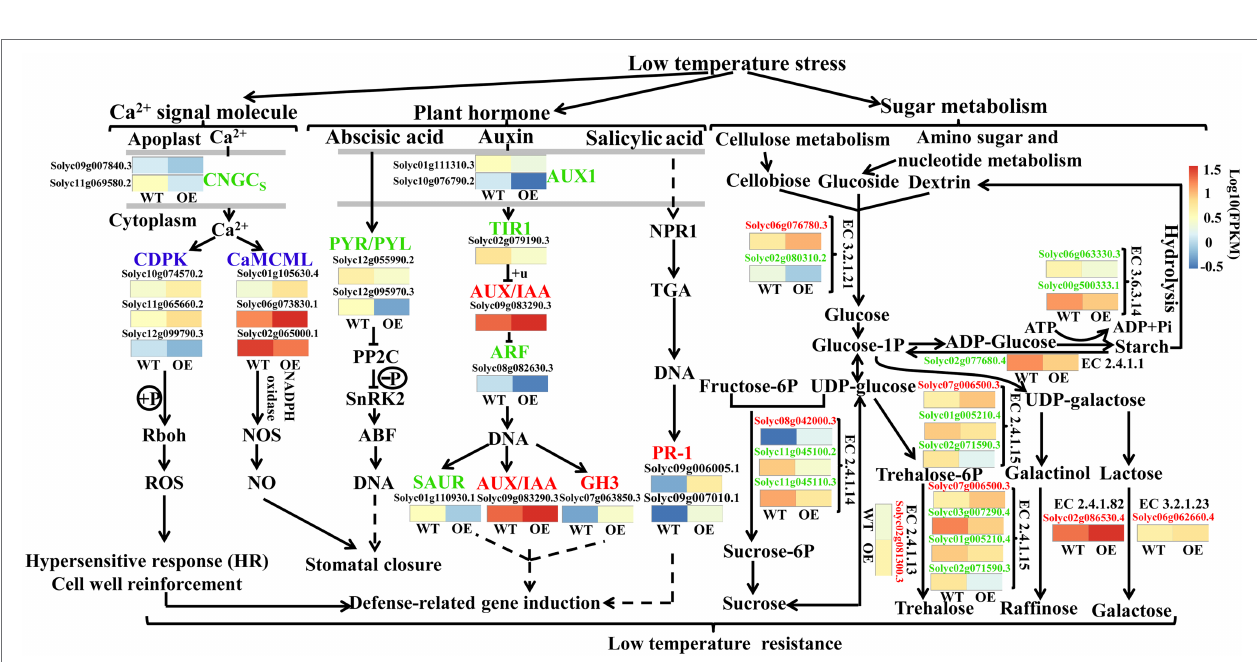
FIGURE 8 | Involvement of other genes in the LT regulatory network in OEs. This regulatory network mainly includes sucrose metabolism, plant hormones, and Ca 2+ signal regulation pathways. Blue color indicates that a protein or enzyme was annotated as both up- and down-regulated genes. Red color indicates that it was only annotated as up-regulated genes. Green color indicates that it was only annotated as down-regulated